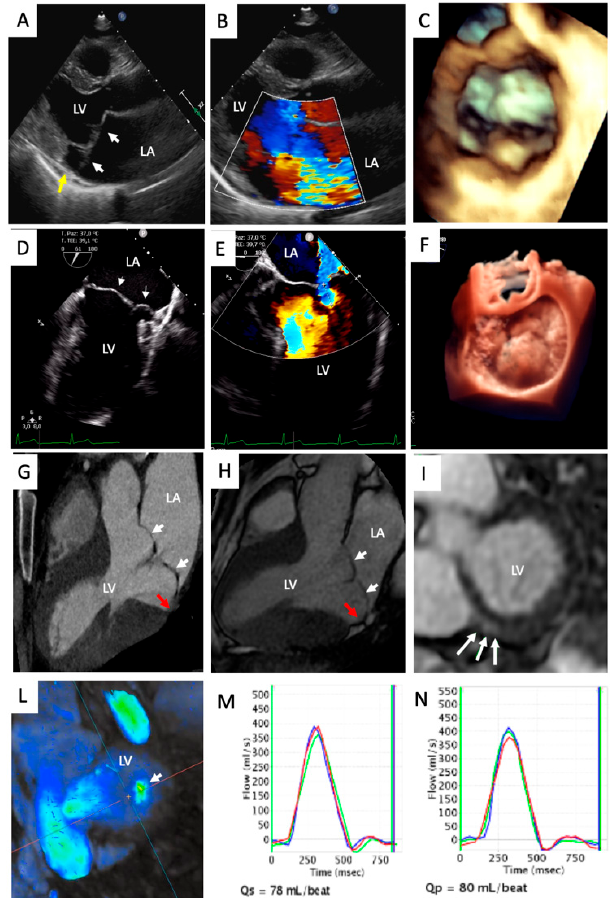
Figure 3. Multimodality MVP assessment in a 37-year-old male symptomatic for exercise dyspnea. ( A ) TTE PLAX view showing a myxomatous MV with bileaflet MVP (white arrows) with associated MAD (yellow arrow); ( B ) ColorDoppler TTE PLAX view showing centrovalvular mitral regurgitation jet; ( C ) 3D-TTE demonstrating bileaflet MVP; ( D ) bicommisural TEE images confirming bileaflet MVP (white arrows); ( E ) TEE 4-Ch view, assessment of mitral regurgitation severity measuring the PISA radius; ( F ) 3D-TEE with photo-realistic 3D rendering confirming bileaflet MVP; ( G , H ) CCT ( G ) and CMR ( H ) confirming the presence of bileaflet MVP (white arrows) with associated MAD (red arrow); ( I ) CMR late gadolinium enhancement images showing focal fibrosis of the LV inferobasal wall; ( L ) four-dimensional (4D)-flow CMR basal short axis view showing centrovalvular mi- tral regurgitant jet; ( M , N ) phase contrast measurements of aortic ( M ) and pulmonary ( N ) flow. CCT: Cardiac CT; CMR: Cardiac Magnetic Resonance; MV: Mitral Valve; MAD: Mitral Annular Disjunc- tion; MVP: Mitral Valve Prolapse; PISA: Proximal Isovelocity Surface Area; PLAX: Parasternal Long Axis; TEE: Transesophageal echocardiography; TTE: Transthoracic Echocardiography.